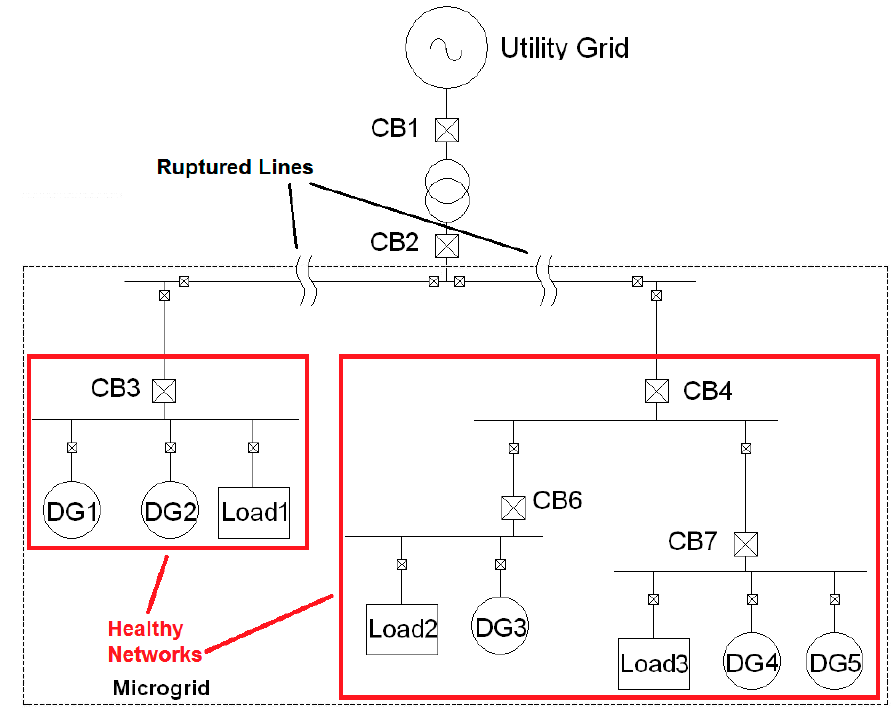
Figure 8. Detection of postdisaster healthy networks.